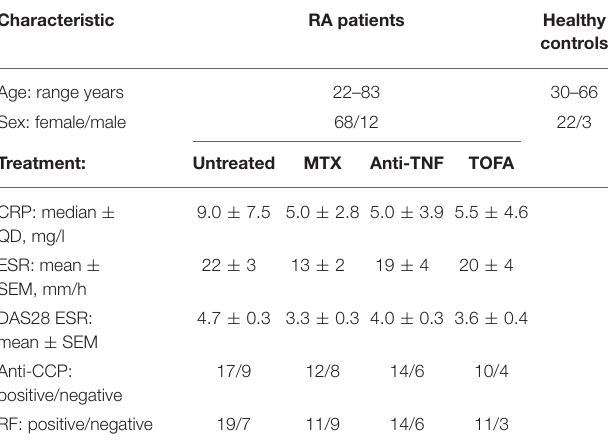
TABLE 1 | Demographic and Clinical Features of RA Patients and Controls. Characteristic RA patients Healthy